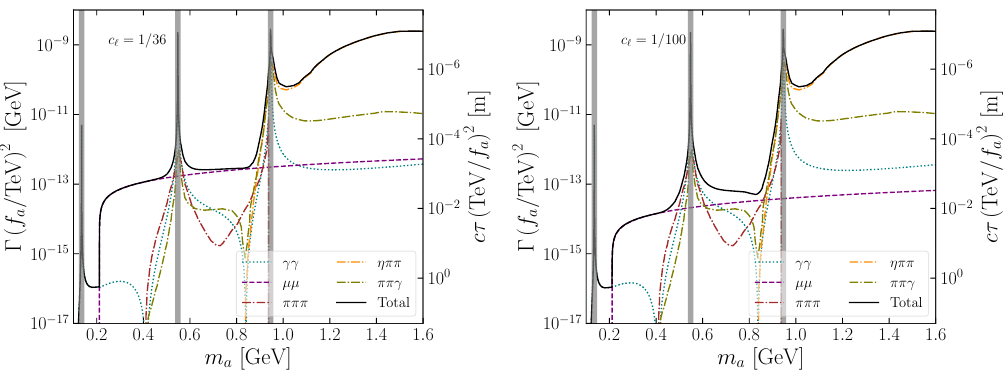
Figure 2 . The relative contributions of various decay channels to the total width of the axion for c ‘ = 1 / 36 (left) and c ‘ = 1 / 100 (right). For 2 m µ < m a . 0 . 8 GeV, the axion dominantly decays into a pair of